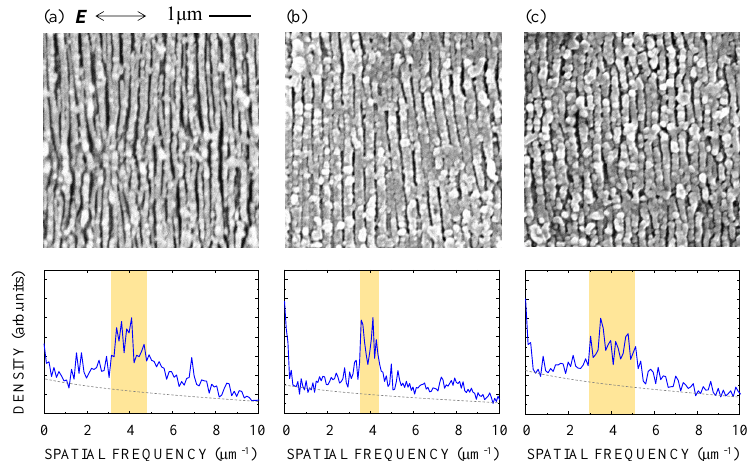
Figure 6. SEM image (upper) and Fourier spectrum (lower) of the silicon suboxide films irradiated with ( a ) N = 250, ( b ) N = 500, and ( c ) N = 1000 fs laser pulses at F = 750 mJ / cm 2 . E denotes the direction of the polarization. The period d is estimated from the half maximum of the spectrum (orange-hatched area in the spectrum).